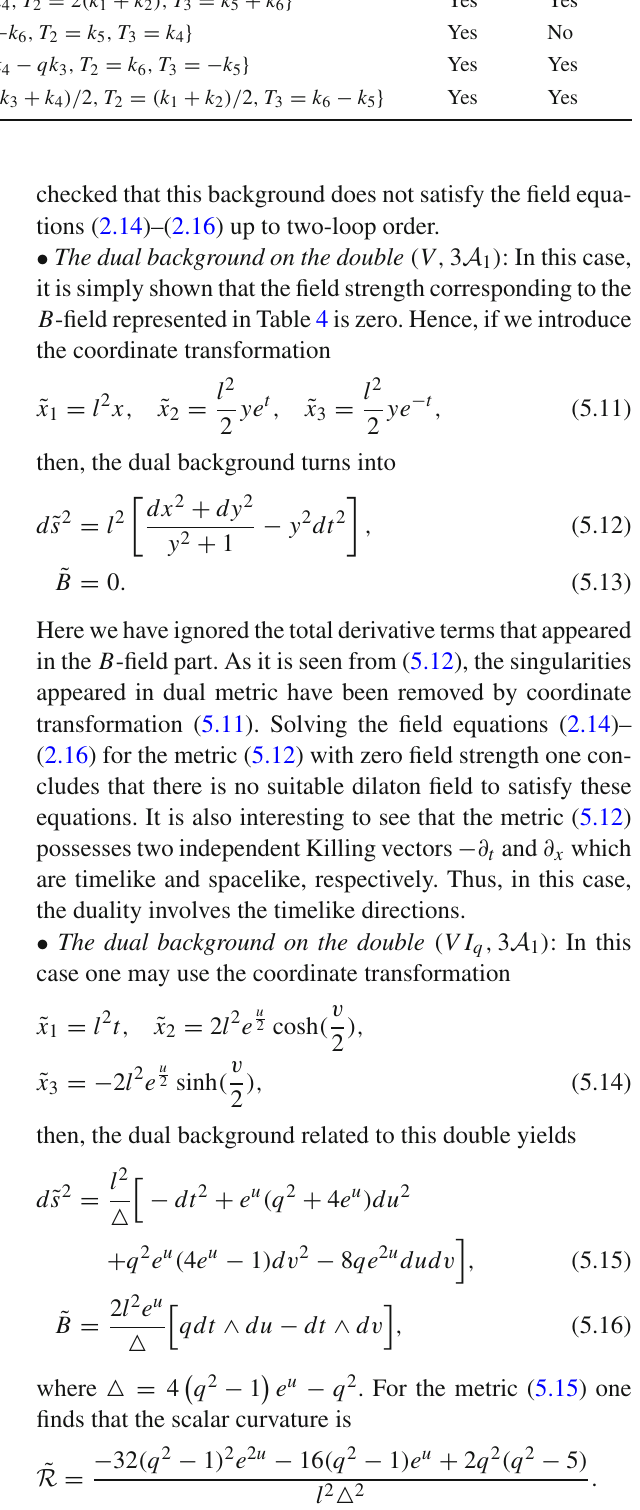
Table 3 Free and transitive actions of three-dimensional isometry Lie subgroups on AdS